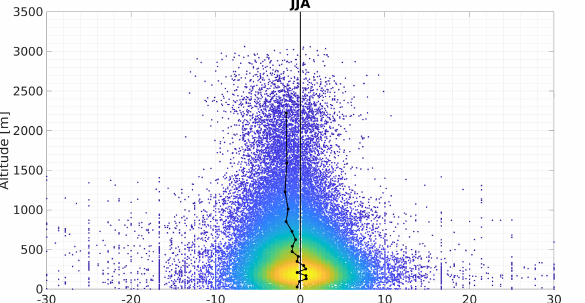
Figure 4. Relative variation in the number of events with at least 3.5ms − 1 upward vertical velocity as a function of surface elevation in JJA. The black line indicates the mean relative variation in 18 classes based on grid cell surface elevation, defined to have the same number of data in each class. Colors represent the density of the points in the GAR (yellow: high density; blue: low